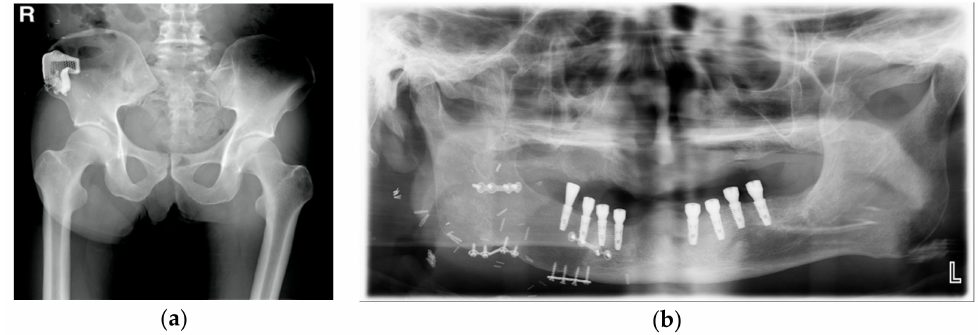
Figure 6. Postoperative radiographs after one year: ( a ) Patient-specific implant shown on the right iliac bone after one year; ( b ) The well-reconstructed mandible; implants were installed one year after the